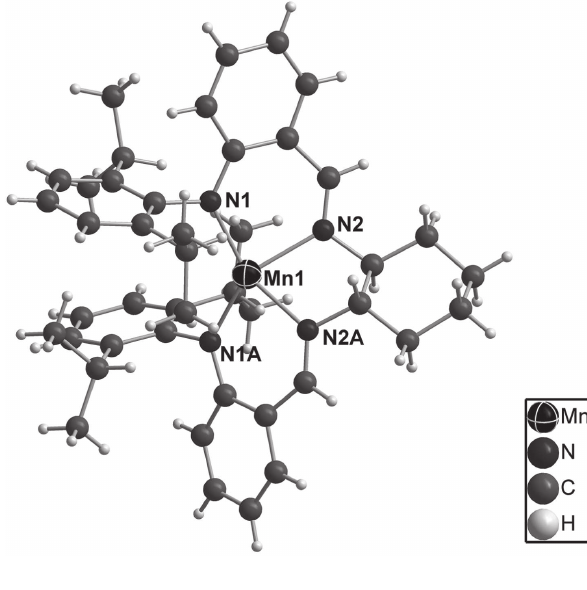
Table 1: Data collection and handling.